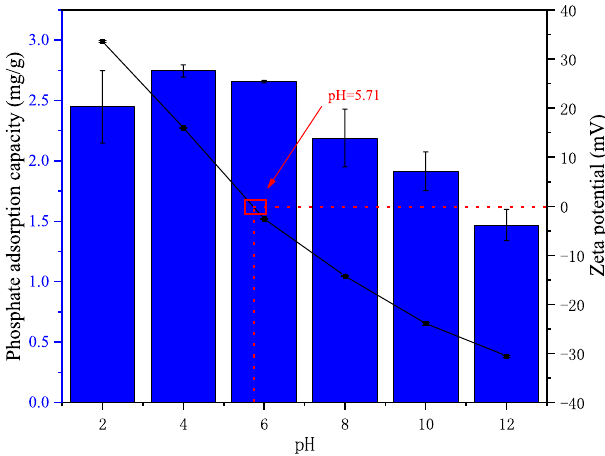
Figure 5. Effect of pH on XT-300 adsorption and zeta potential.